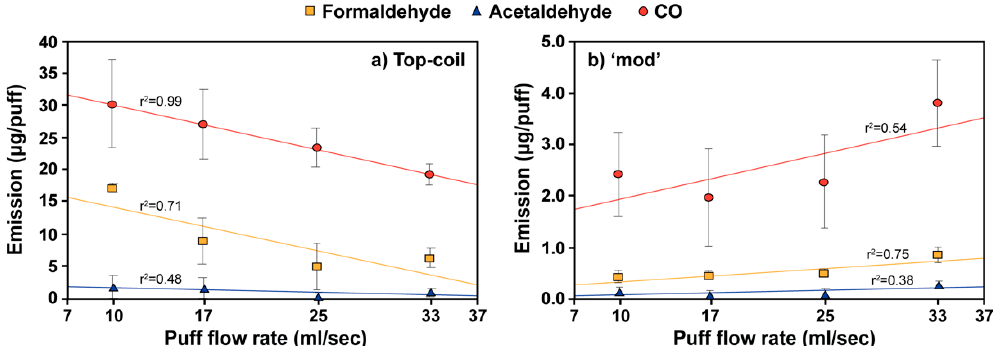
Figure 3. Impact of pu ff flow rate on carbonyl and CO emissions for the ( a ) top-coil and ( b ) ‘mod’ e-cigarette devices for a 4-s pu ff duration. The tested flow rates of 10, 17, 25, and 33 mL / s correspond to 40, 67, 100, and 133 mL pu ff volumes. A 50-watt power output was used for ‘mod’ device. Error bars represent standard deviation of three independent measurements. Regression lines for each compound are also shown.